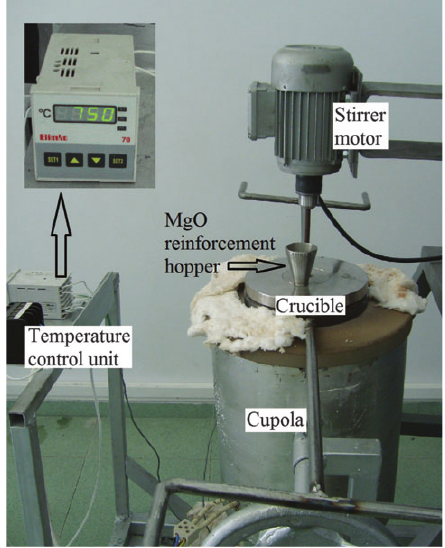
Figure 1 Melt-stirring experiment apparatus (Kırıkkale University, Metallurgy and Material Department Laboratory). Table 2 Cutting parameters and associated values used in machin- ing